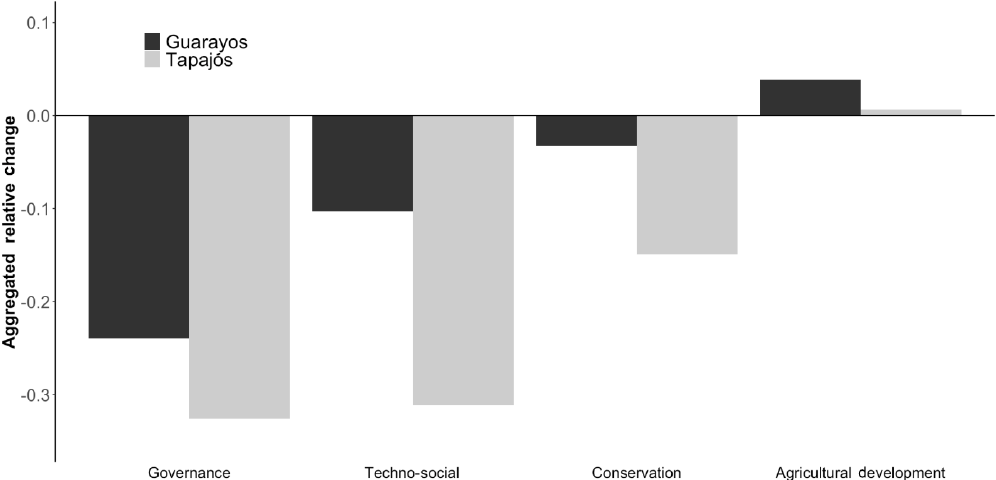
Figure 8. Aggregated relative change and response of scenarios, compared with baseline. Negative values represent a desirable change in the system. Positive values represent an undesirable change in the